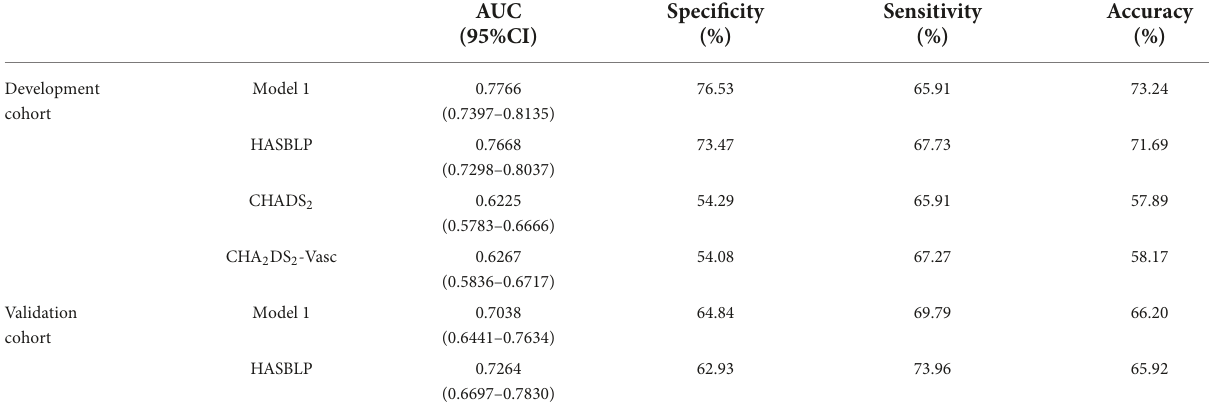
TABLE 2 Area under curve of receiver operating